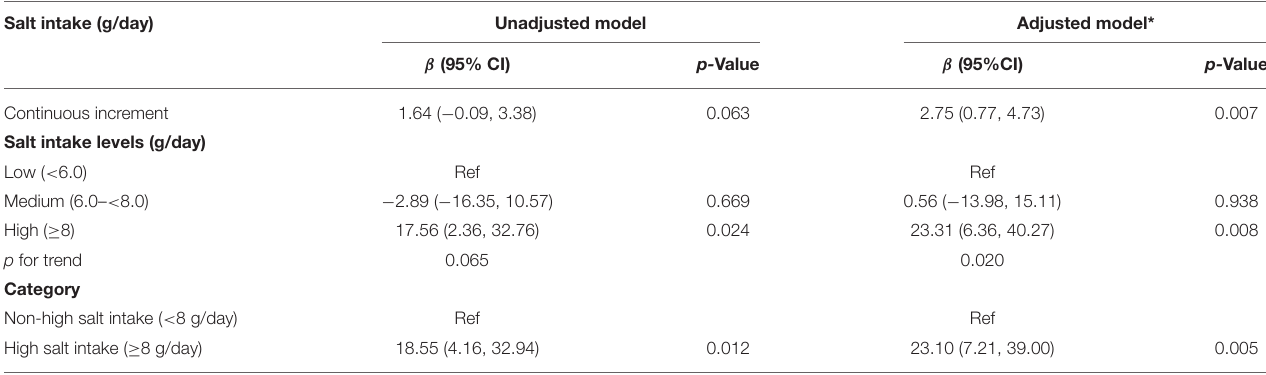
TABLE 4 | Association between salt intake and decline of RRF.